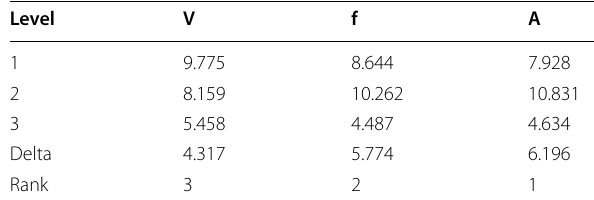
Table 9 S/N response and the delta value of Ra for